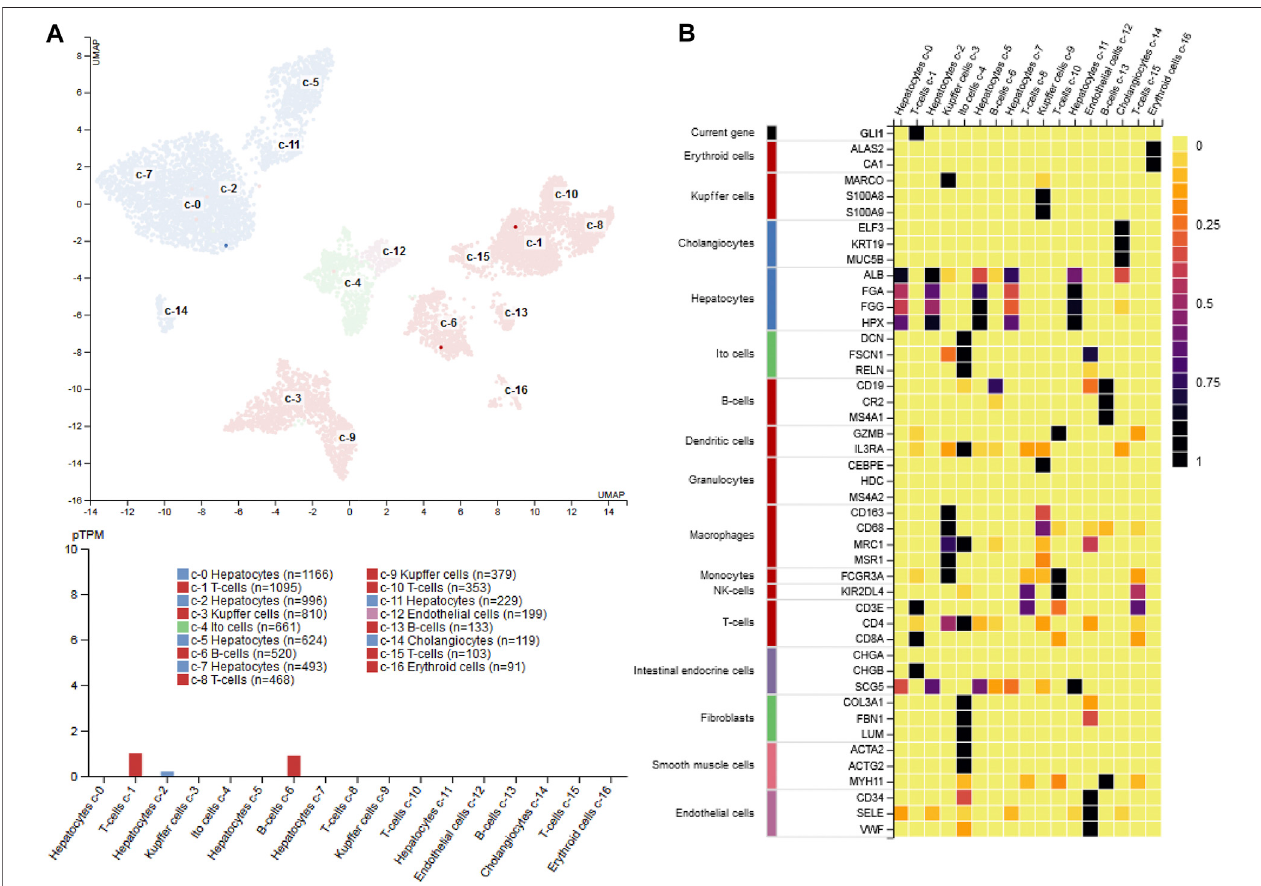
FIGURE 11 | GLI1 expression in liver (A) single cell PCR data shows that GLI1 mRNA expression in normal human liver is rather low ( < 1 protein-coding transcript permillion)andmajorlyrestrictedtoasubpopulationofT-cells,B-cellsandhepatocytes (B) Heatmapofmarkergeneexpressionindifferenthepatic celltypes.The fi gure wascompiledusingexpressiondatafromtheHumanProteinAtlas(www.proteinatlas.org/)(Uhlénetal.,2015).Abbreviationsusedare:pTPM,protein-codingtranscript per million; UMAP, uniform manifold approximation and